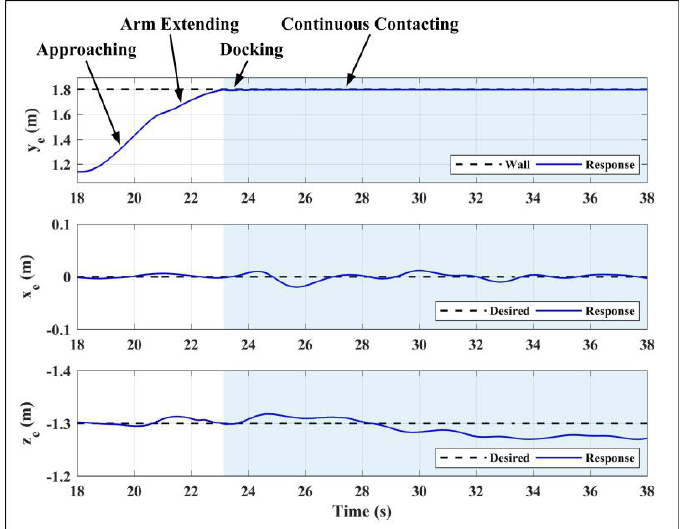
Figure 17. End e ff ector position responses in Scenario Figure 17. End effector position responses in Scenario 3.